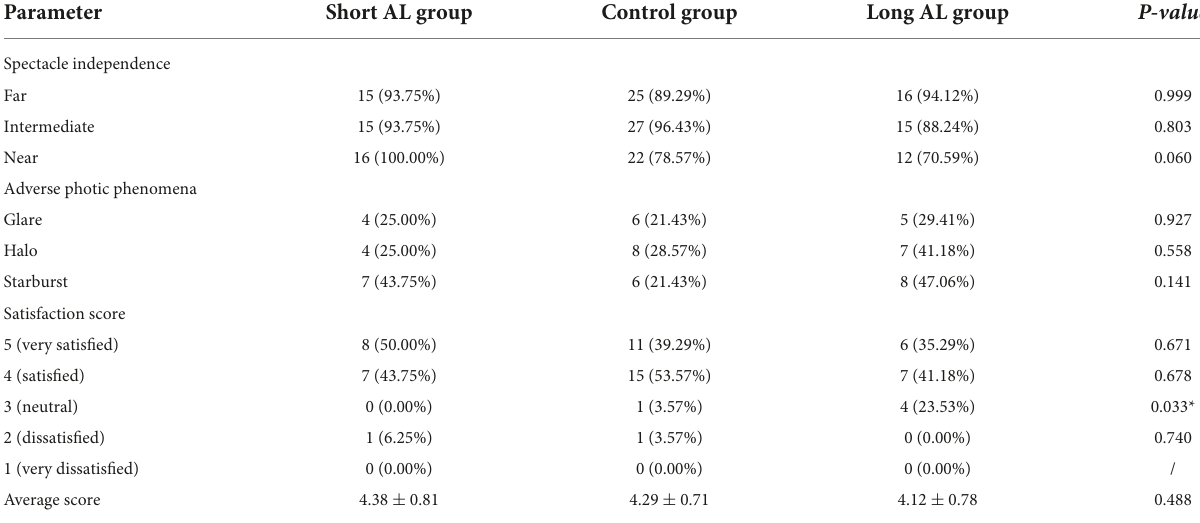
TABLE 4 Spectacle independence, adverse photic phenomena and overall satisfaction.